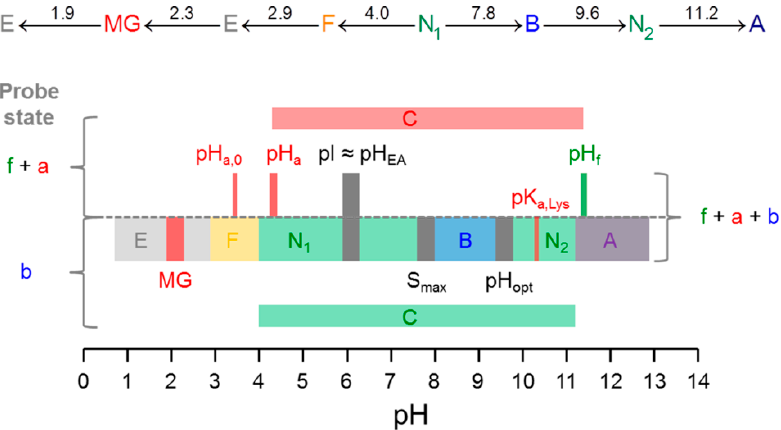
Figure 11. pH ‐ induced functional phase space of HSA. A condensed graphical overview is given about all observables from EPR spectroscopy (and DLS experiments) that can be found in Table S11. The pH ‐ induced conformational isomers in the elongated (E, gray), fast migrating (F, yellow), norm (N 1 and N 2 , green), basic (B, blue) and aged form (A, purple) are identified in an averaged phase space bar in the range of pH 0.7–12.9. The compact form (C) comprises the N 1 , B and N 2 isomers and can be obtained from free ligand ( f + a , red bar), bound ligand ( b ), 5 ‐ MSL HSA, or from DLS (green bar). The MG state (red, left) and the pH of maximum ligand order ( S max , black) are exclusively obtained from spin probing experiments. An isoelectric point (pI, black) can be extrapolated from both, the bound and free ligands ( f + a + b ) and is detected as a kind of electrostatic activation of ligands (pH EA ). The I abf parameter monitors the behavior of the free ligands and elucidates the acidic (pH a ) and basic onset of FA release (pH f ) with a clearly extractable maximum rate of aggregate formation (pH a ,0 ). The point of maximum HSA stability (pH opt ) and the collective lysine p K a (p K a,Lys ) can be either calculated, or are also detected in several EPR-based data sets. The color coded isomerization scheme (top) is given with corresponding averaged pH values with N 1 as the main physiologically functional cardinal point.